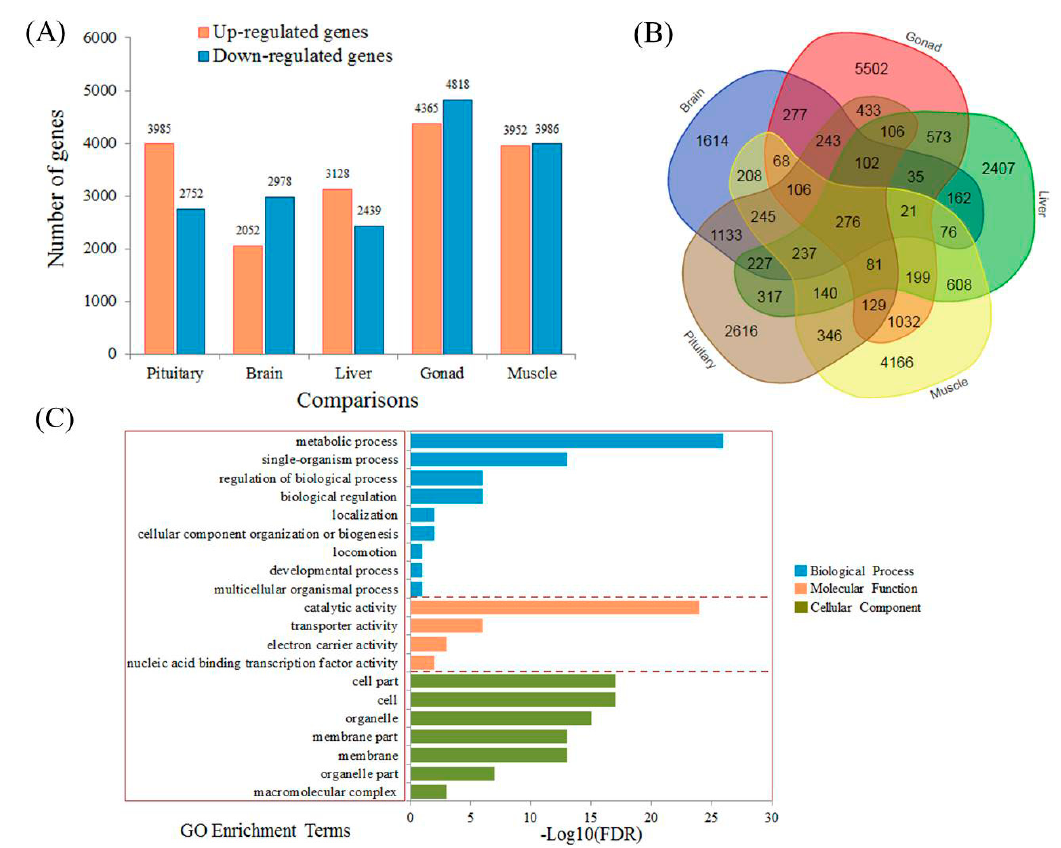
Figure 2. Differentially expressed genes (DEGs) obtained by pairwise compassion in five tissues of M. anguillicaudatus . ( A ) The number of identified DEGs in each tissue; ( B ) the five-way Venn diagram of the DEGs identified from the five tissues; ( C ) DEGs overlapped among tissues. Table 1. Some key DEGs associated with growth and ovarian maturity identified by the pairwise-comparisons of diploid and tetraploid M. anguillicaudatus .